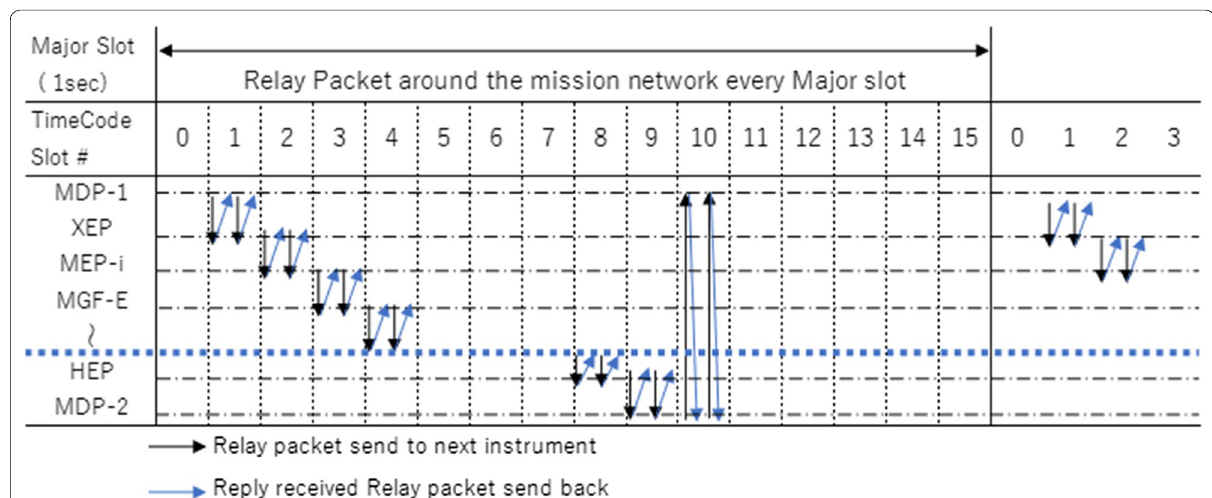
Fig. 5 Diagram of the relay packet transmission in the mission ring